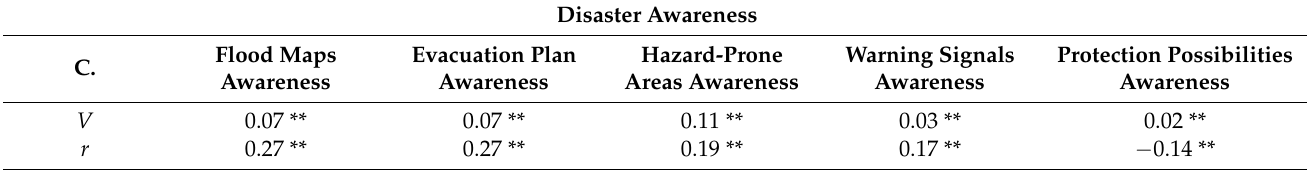
Table 8. Association and correlation between the dependent variable and disaster awareness variables.